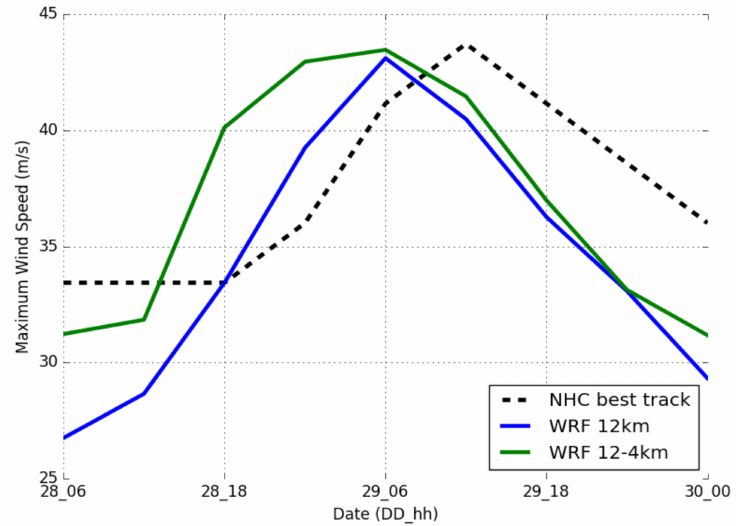
Figure 3. Cyclone wind speed from NHC best track (dashed black line); WRF 12 km simulation (blue); and WRF 12-4 km simulation